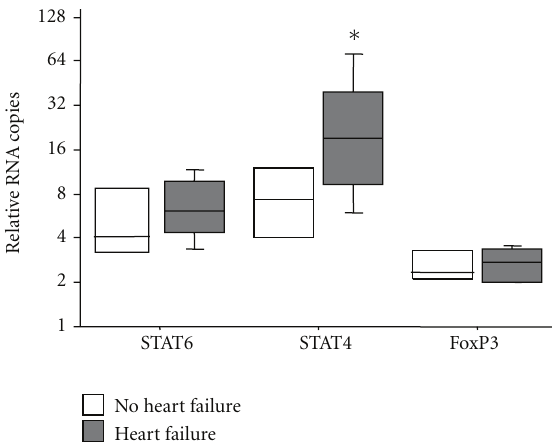
Figure 5: Relative number of mRNA copies in heart tissue of patients in the chronic phase of Chagas’ disease according to the presence (gray bar) or absence of heart failure (open bar). Horizontal lines represent the median, boxes represent the 25th to 75th percentiles, and vertical lines indicate the 10th to 90th percentiles. ∗ P < 0 . 05 (Mann-Whitney